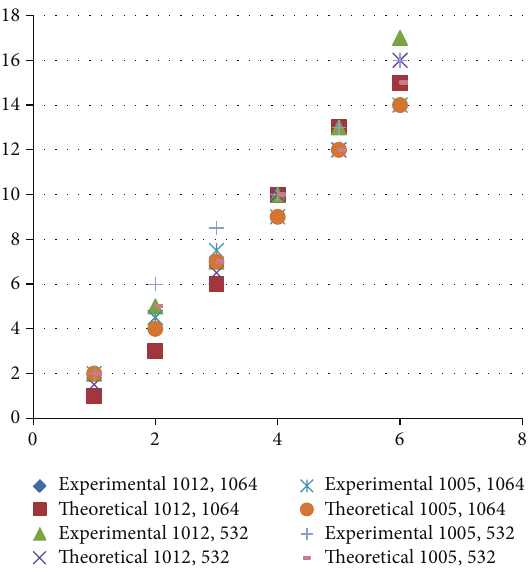
Figure 2: Removed depth at different PRR, wavelengths of 1064 and 532, and peak power of 40 MW for AISI1012 and